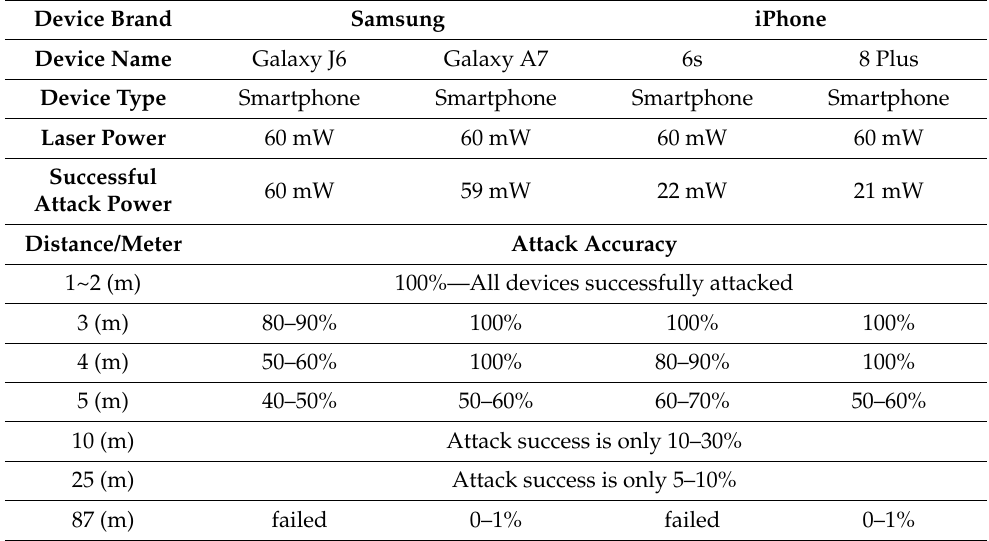
Table 4. Distance